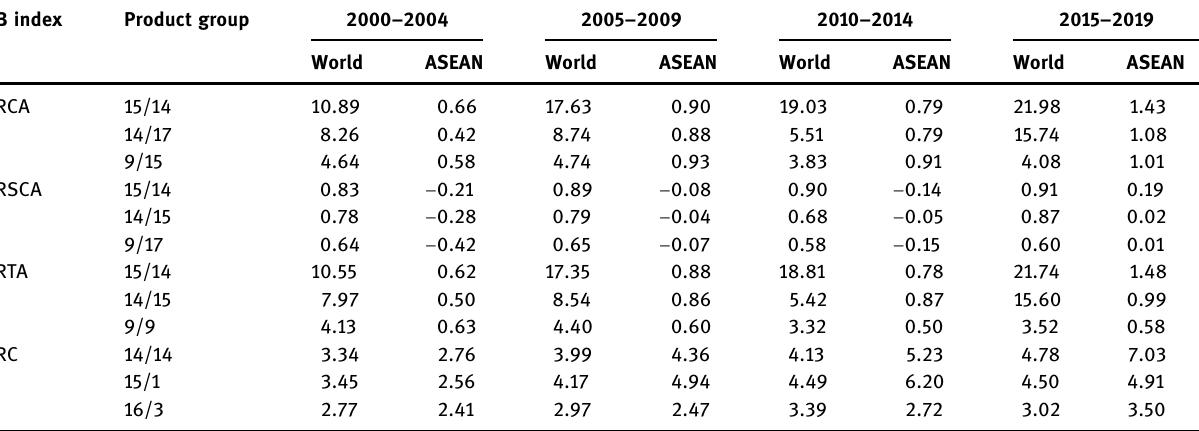
Table 6: The three highest Balassa indices of Indonesia at World and ASEAN level, 2000 –